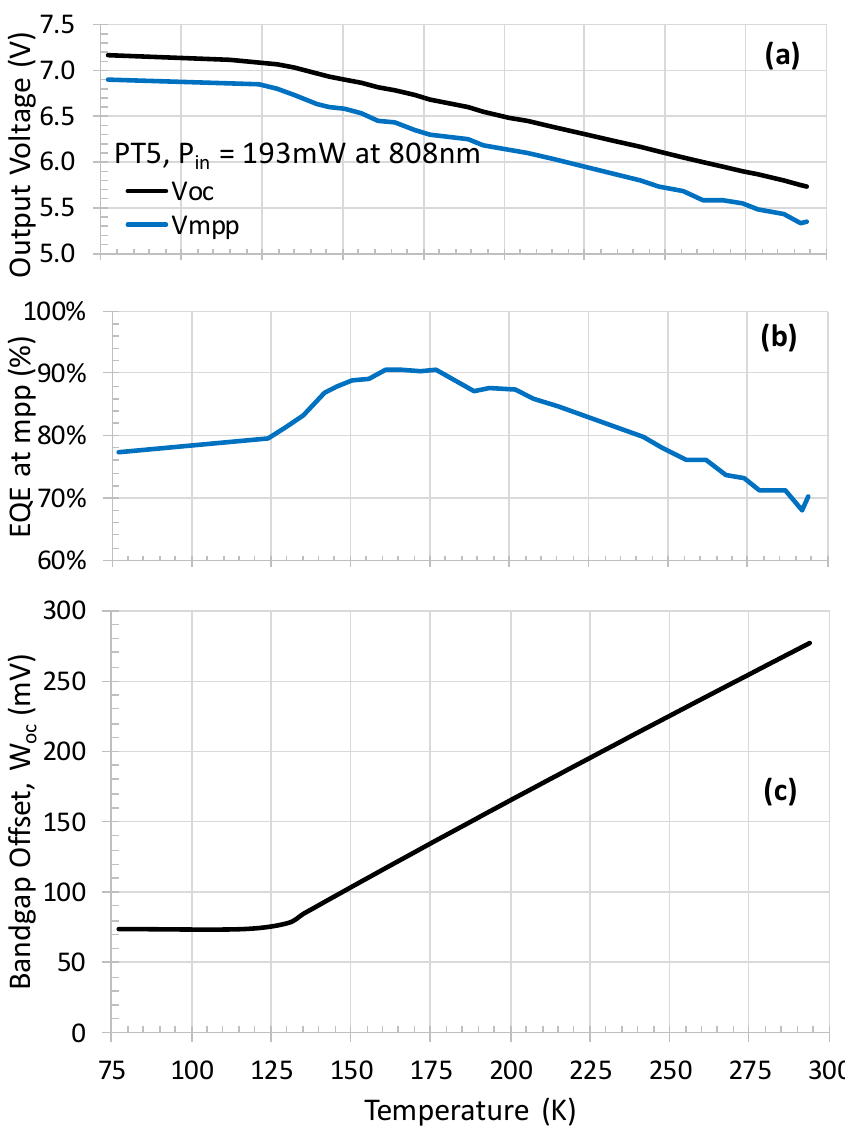
Figure 5. Temperature dependence of the output voltage in ( a ), the external quantum efficiency (EQE at mpp) in ( b ), and the bandgap offset (W oc ) in ( c ).